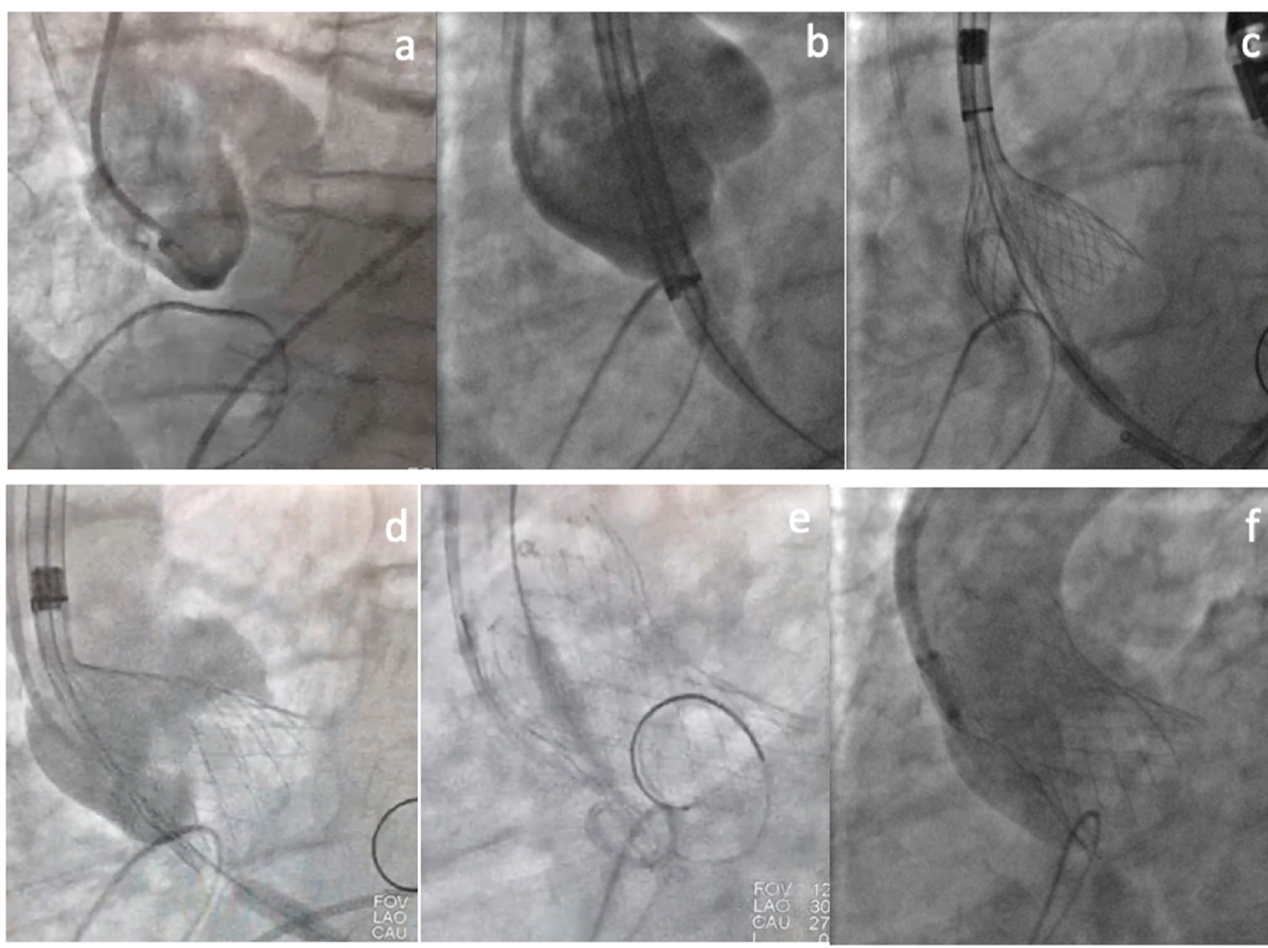
Figure 3. TAVI intraprocedural steps: two pigtail catheters positioned in the aortic Sinuses of Valsalva ( a ); Transcatheter heart valve initial deployment position ( b ); TAVI slow deployment under rapid ventricular pacing ( c ); implant height (3–5 mm depth) ( d ); careful nose cone removal ( e ); TAVI final deployment position ( f ).